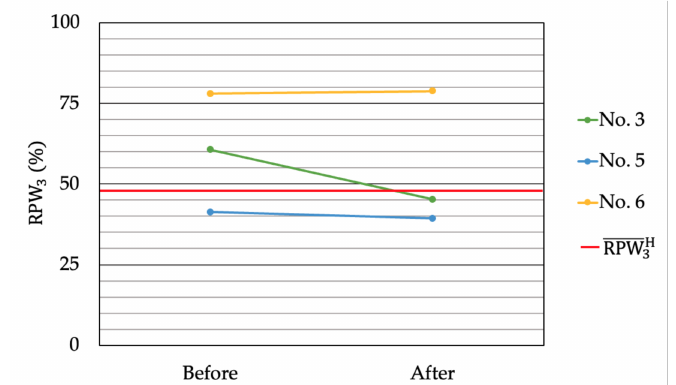
Figure 9. Results of RPW 3 before and after applying local vibratory stimulation to the Vater-Pacini corpuscle. RPW 3 indicates the relative proprioceptive weighting ratio of the Vater-Pacini corpuscle, and RPW H 3 indicates the mean value of RPW 3 for healthy adults (Supplemental Table